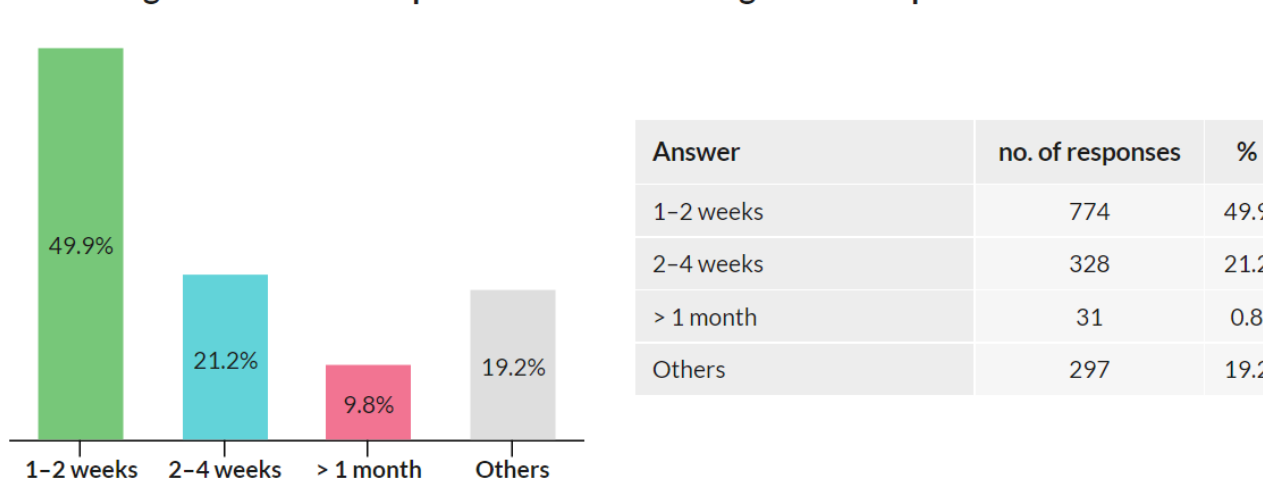
Figure 5. Time range of Czech dental practices closure during the whole pandemic.